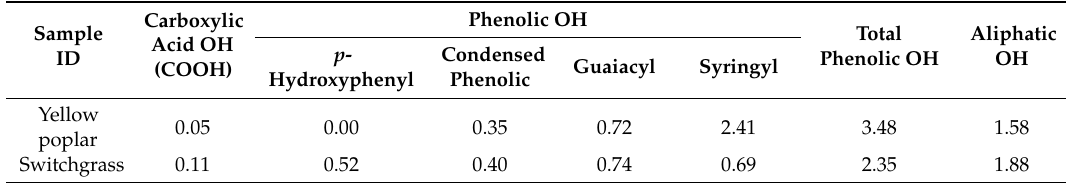
Table 2. Hydroxyl group contents of lignin samples obtained by quantitative 31 P NMR spectroscopy (mmol g − 1 ).